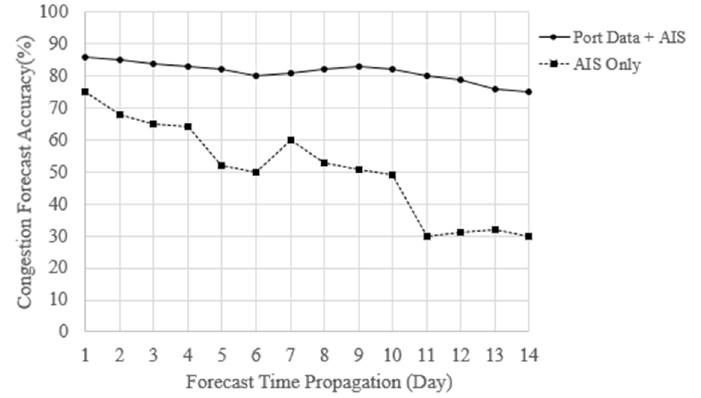
Figure 10. Variations in accuracy when using AIS data only and the hybrid case.